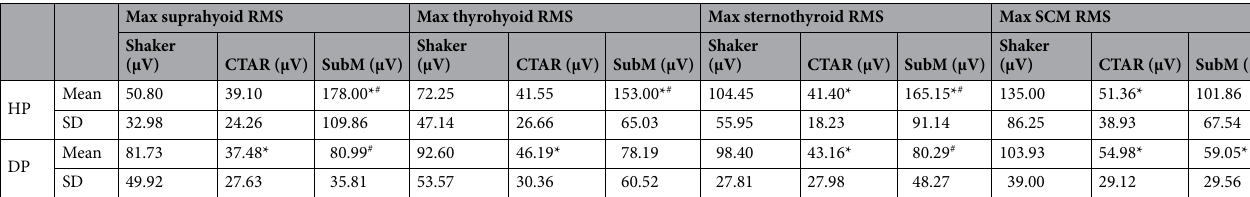
Mean Suprahyoid RMS Mean Thyrohyoid